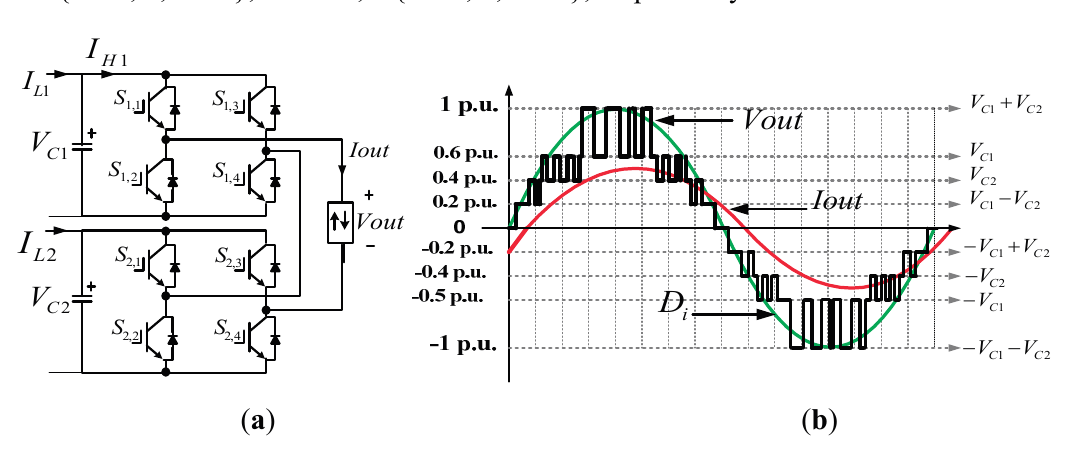
Figure 5. Nine levels DC/AC cascaded hybrid converter ( a ) topology; ( b ) V out waveform. Table 3. Switching states and respective voltage